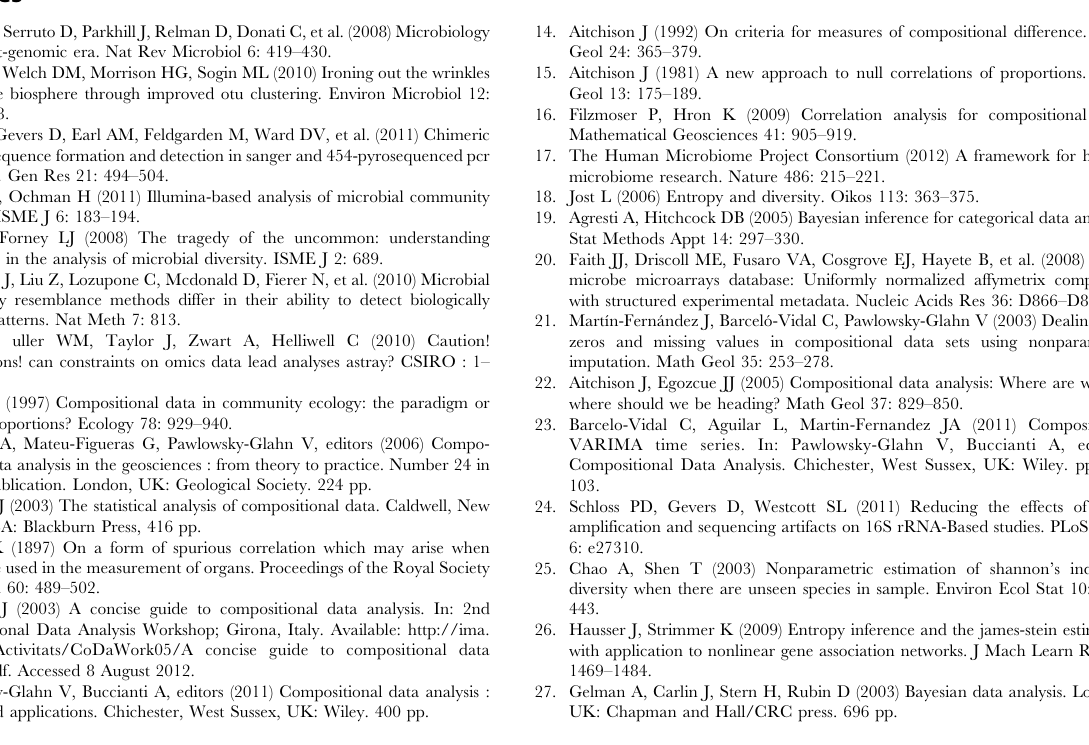
Figure S5 SparCC is more accurate than alternative correlations even when considering only the strongest detected correlations. RMSE of SparCC, Pearson and Spearman correlations whose inferred magnitude exceeds a given threshold. Data is simulated as described in Materials and Methods section of main text. Note that the Spearman correlations estimated from the fractions were compared to the true basis Spearman correlations, rather than Pearson correlations. Figure S6 HMP correlation networks inferred using SparCC. Networks inferred using SparCC from the same data as in Fig. 6. This figures is extends Fig. 4 to include all 18 HMP body sites. Table S1 Accuracy of HMP Pearson networks compared to SparCC networks. Table S2 Correlation between OTUs decreases with phyloge- netic